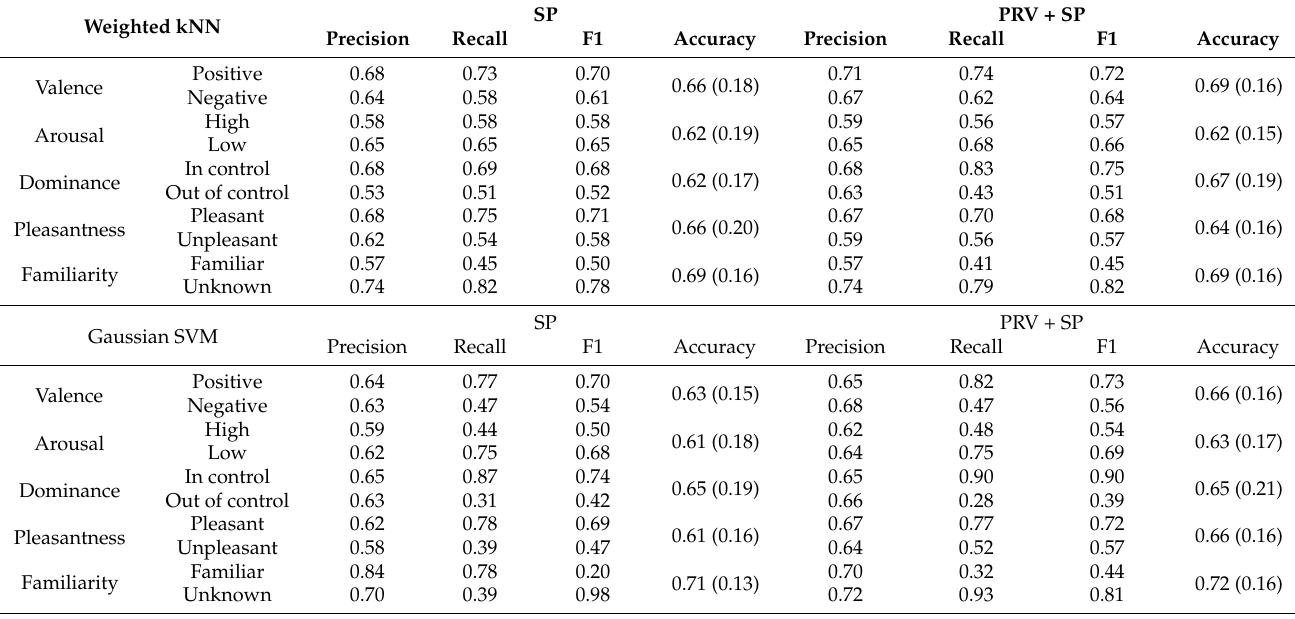
Table 7. Classification metrics: shape parameters (SP) versus PRV + SP.